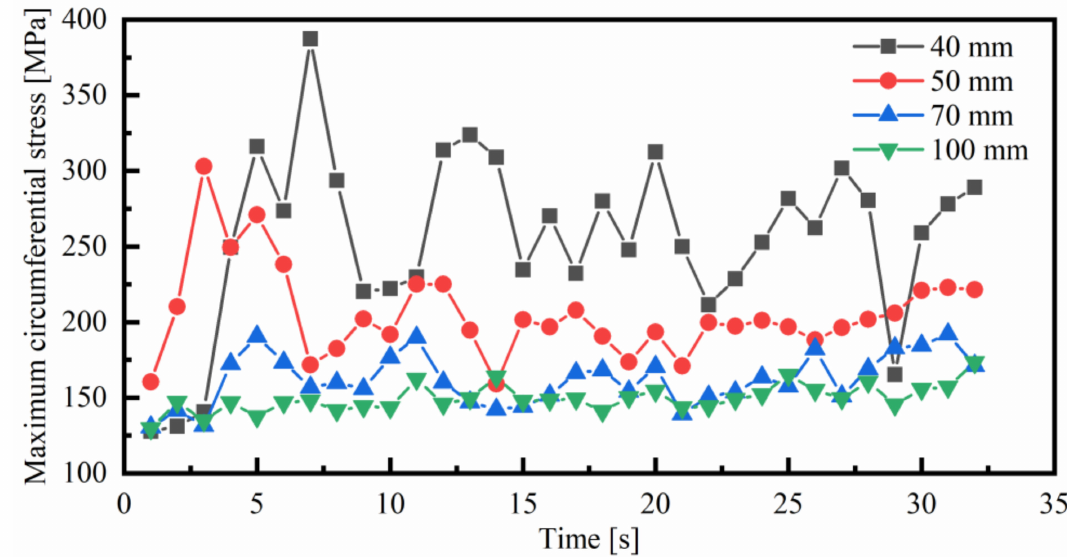
Figure 24. History curves of the maximum circumferential stress with different distances between the inductor and the bending roller (feed rate of the tube: 10 mm/s).